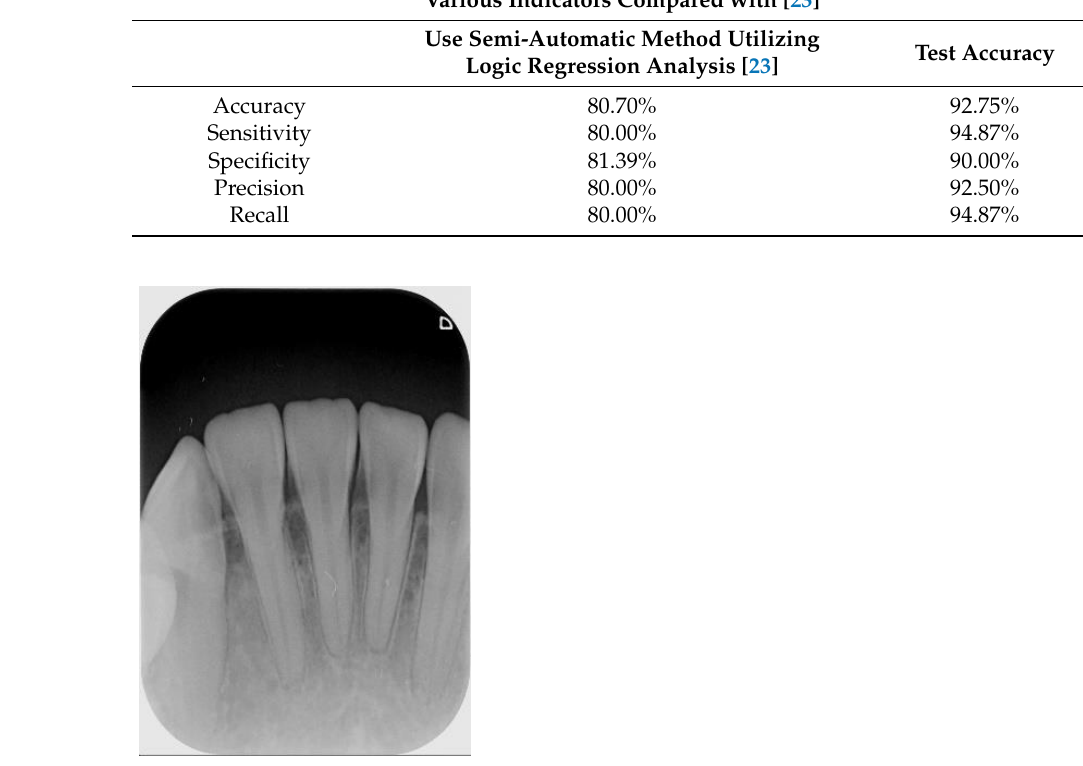
Figure 7. Outer example for validation (number 1 to 5 from left to right).